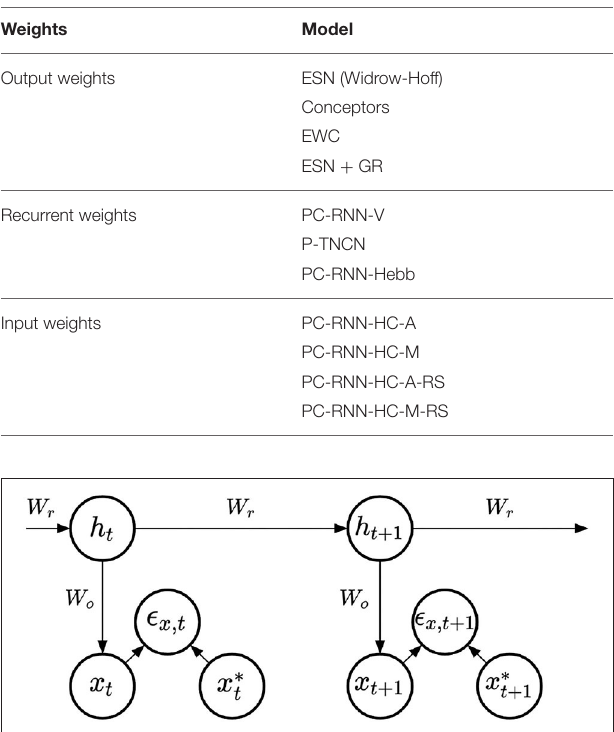
FIGURE 2 | Simple RNN